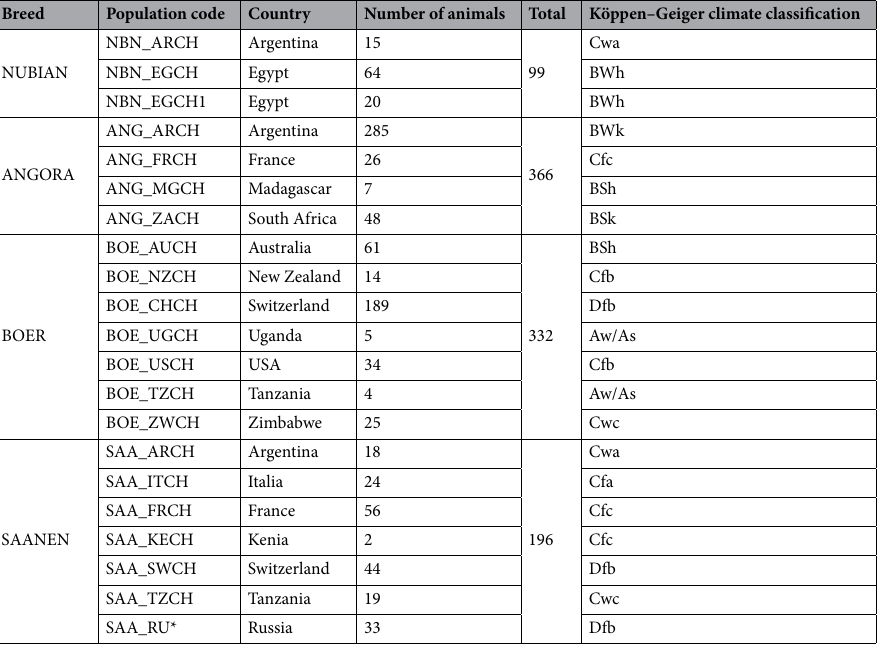
Table 5. Breed and population code, country and number of samples used in the study. We added the Köppen–Geiger Climate Classification for further considerations. *This population is not from the AdaptMap dataset. The Köppen–Geiger Climate Classification Map ranged from the year 1980 to 2016. Legend of the Map: Aw = Tropical/Dry winter As = Tropical/Dry summer; BWh = Arid/desert/hot; BWk = Arid/desert/ cold; BSh = Arid/Steppe/Hot; BSk = Arid/Steppe/Cold; Cfc = Temperate/No dry season/Cold summer; Cfb = Temperate/No dry season/warm summer; Cwc = Temperate/Dry winter/Cold summer; Cwa = Temperate/ Dry winter/Hot summer; Cfa = Temperate/No dry season/Hot summer; Cfc = Temperate/No dry season/ Cold summer; Dfb = Continental/No dry season/Warm summer. From https:// en. wikip edia. org/ wiki/K% C3% B6ppen_ clima te_ class ifica